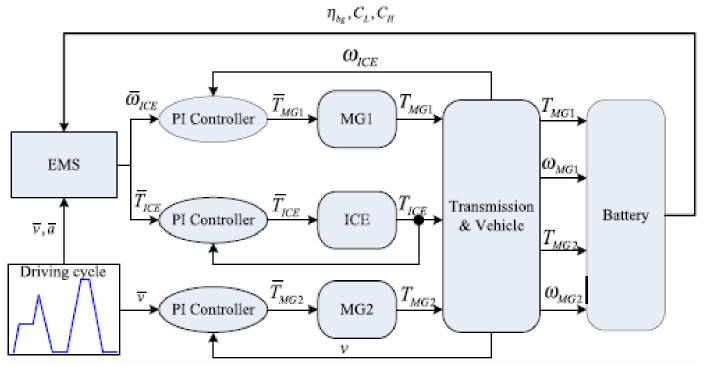
Figure 21. Control structure of power system for the vehicle [23].